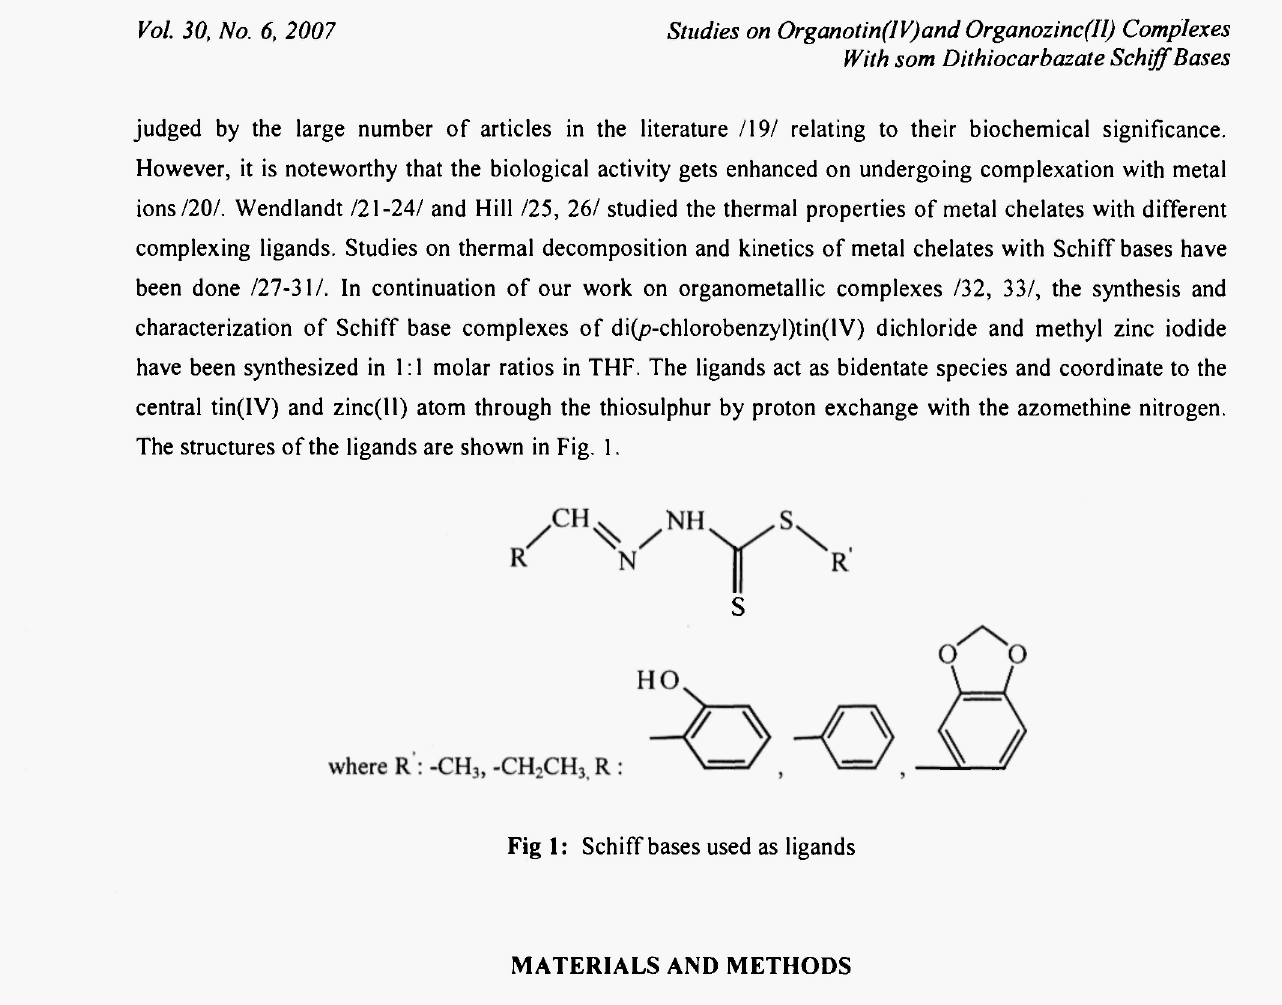
Fig 1: Schiff bases used as